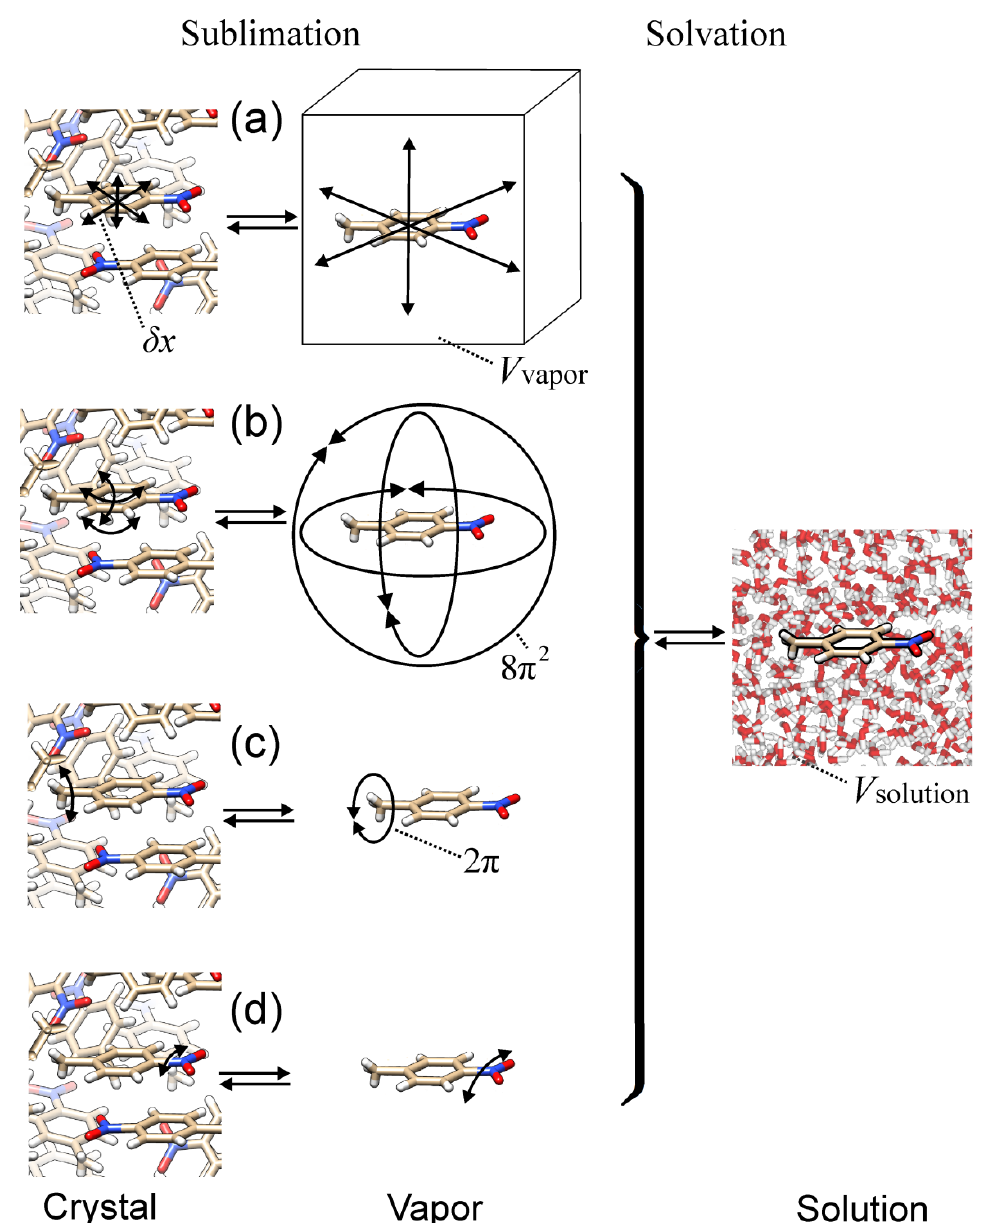
Figure 1. A scheme of the considered processes: reversible sublimation (from crystal (left column) to vapor (middle column)) and reversible solvation (from vapor (middle column) to aqueous solution (right column)). Four considered types of movements available in vapor (middle column) but hindered in crystal (left column): ( a ) translational movements of the considered molecule as a whole in vapor and the corresponding movements (vibrations) in a crystal; ( b ) rotational movements of the molecule as a whole in vapor and the corresponding vibrations in a crystal; ( c ) rotations around a covalent bond with a low potential barrier in vapor and the corresponding vibrations in a crystal; ( d ) vibrations around a covalent bond with a moderately high potential barrier in vapor and the corresponding vibrations in a crystal. δ x is the range of movements of the considered molecule in crystal; V vapor and V are the solution volumes per crystal-forming molecule in vapor and in solution,